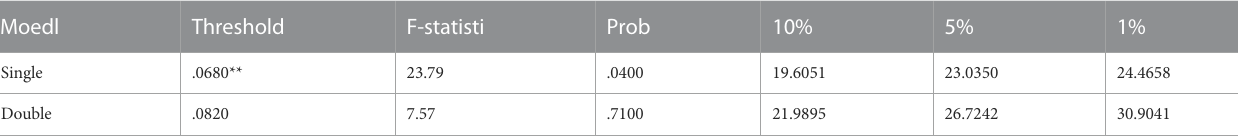
TABLE 8 Threshold test.